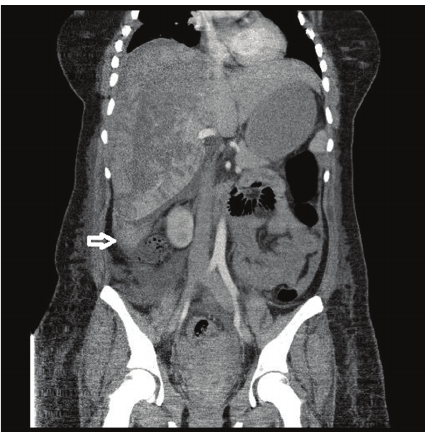
Figure 1: Computed abdominal tomography (CT) scan showed